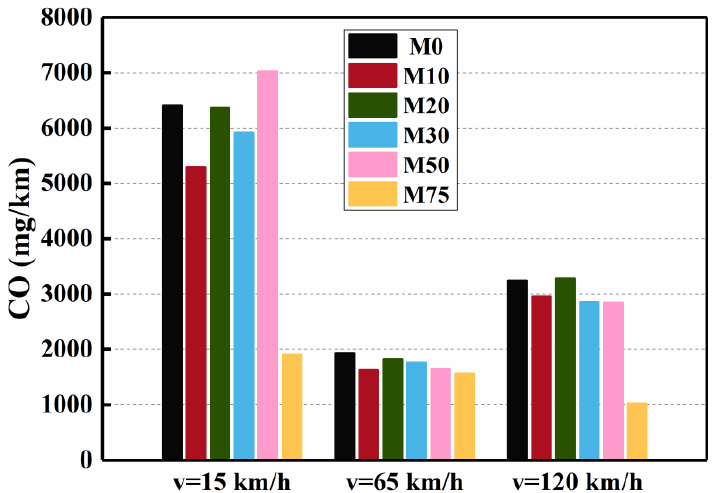
Figure 6. Effects of different methanol blending ratios on CO emissions at different vehicle speeds.